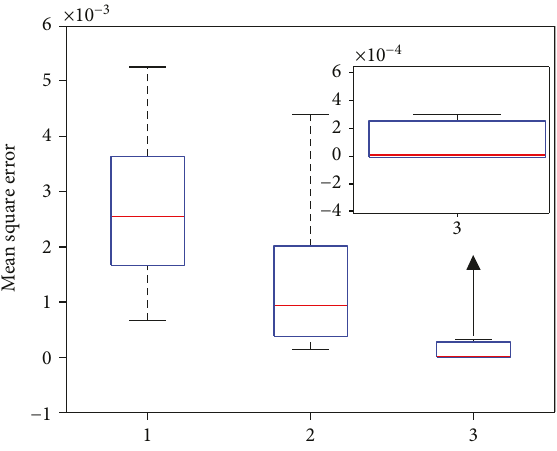
Figure 6: Comparison analysis of the mean square error.